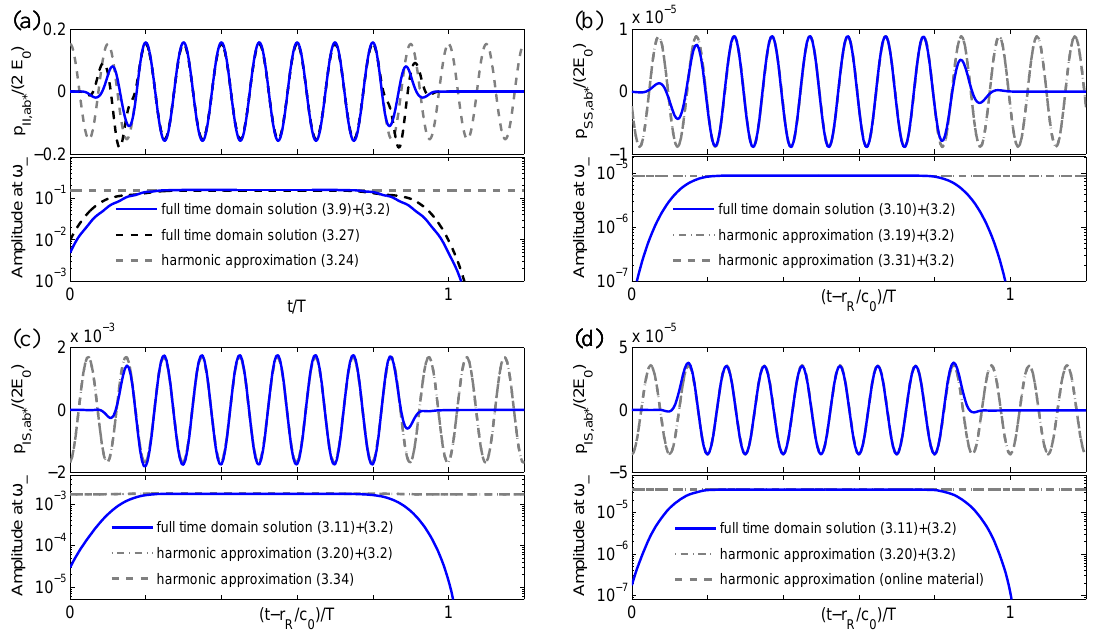
Figure E1. Second order wave due to the interaction of ( a ) incident waves of compact support (II), ( b ) scattered waves (SS) of compact support, ( c ) incident and scattered waves (IS) of compact support in the forward ( c ), and backscatter ( d ) direction by direct numerical integration of the indicated full time domain solutions (solid lines). The second order waves have compact support within which the indicated harmonic approximations are shown to be valid. The top panels show the real pressure and the bottom panels show the pressure amplitude at the difference frequency. Here ω a / ( 2 π ) = 500 kHz, ω b / ( 2 π ) = 300 kHz, T = 50 µ s, c 0 = 1500 m/s and β = 3.6. The pressure is normalized by 2 E 0 , where ) . In ( a ), the pressure is calculated at the origin; in ( b – d ), the pressure is calculated E 0 = | P a 0 P b 0 | / ( 2 ρ 0 c 2 0 at r R = 0.1 m from the center of a pressure release sphere of radius a = 10 µ m and the scattered waves are approximately spherically symmetric with scatter functions S a , b = − k a , b a